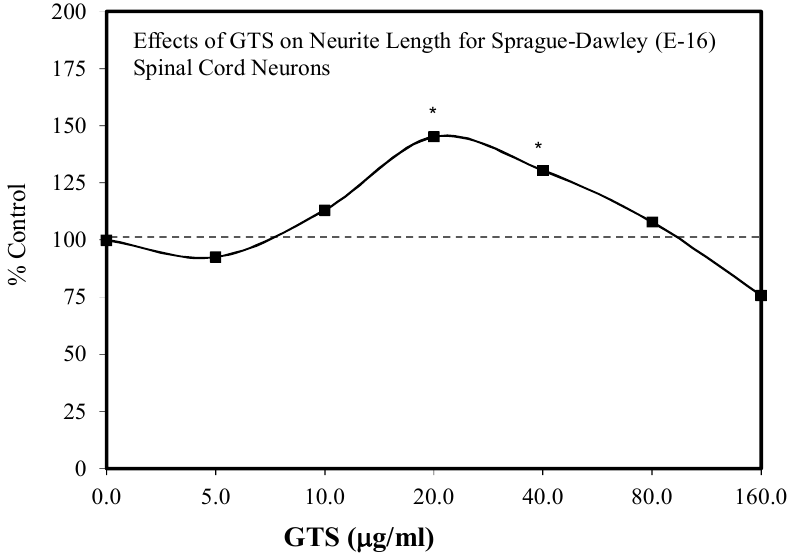
Figure 43. Effects of GTS on neurite length for Sprague–Dawley (E-16) spinal cord neurons (source: [24]). Each * represent statistical significance for a data point.